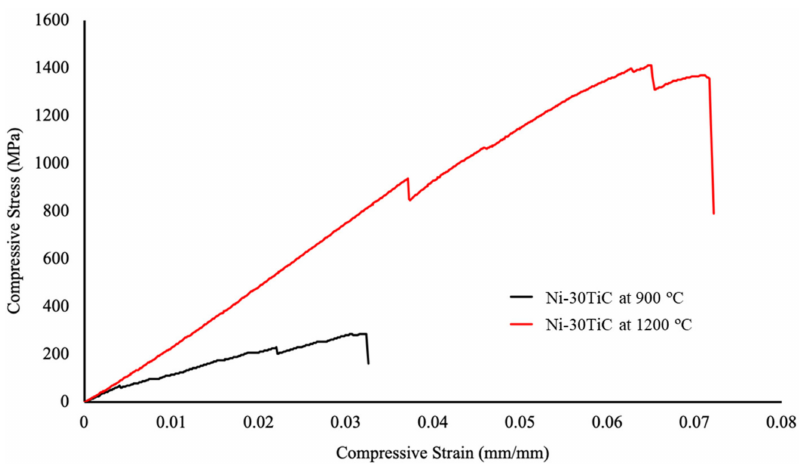
Figure 7. Compressive stress versus strain plots of Ni-30 TiC composites sintered via 900 ◦ C and 1200 ◦ C.